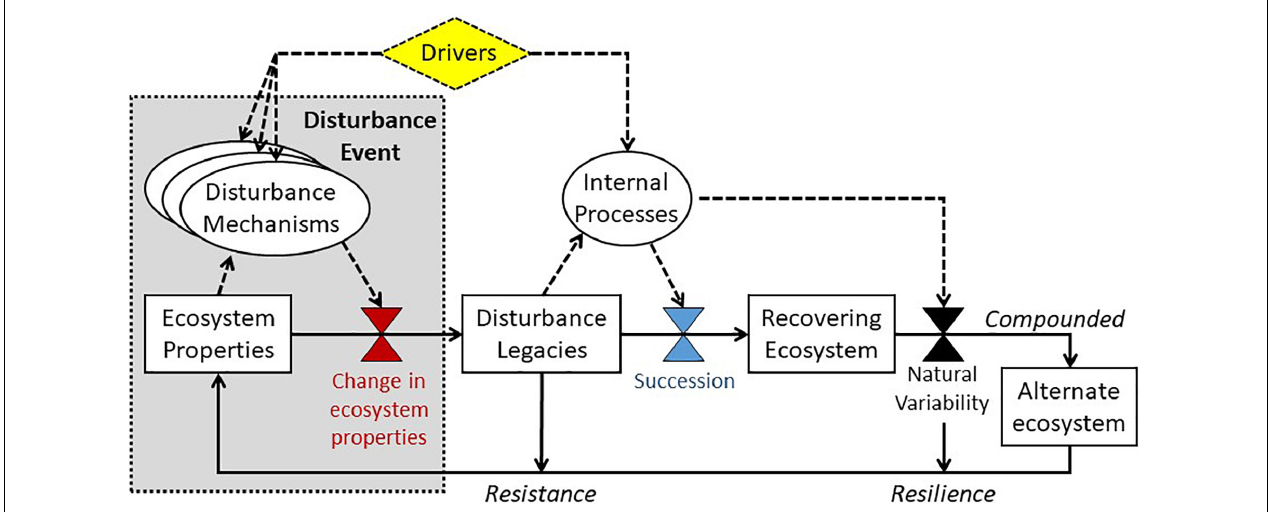
FIGURE 5 | Disaggregating disturbance mechanisms, drivers, and internal processes affecting ecosystem response to disturbance interactions. Drivers (yellow) refer to the microscale and macroscale factors affecting mesoscale dynamics in Figure 1 . Hourglass symbols represent system changes that can either be abrupt (red – rapid disturbance effects), gradual in time (blue – succession), or gradual in space and time (black – natural variability in local system states). Depending on the degree of change in system properties, the legacies that remain, and the recovery processes, the mesoscale ecosystem response can be one of resistance, resilience, or (if overlapping disturbances compound to impede recovery processes) transformation to an alternative system. (Adapted from Peters et al.,